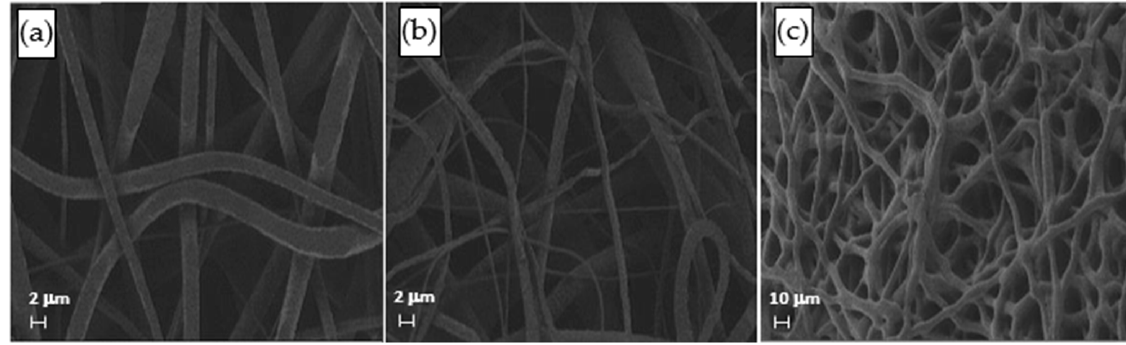
Figure 3. SEM micrographs of the samples ( a ) T1, ( b ) T2, and ( c ) T4 .